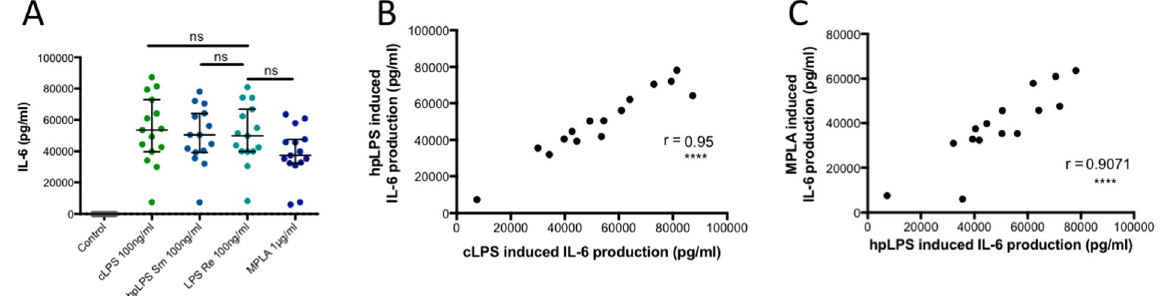
Figure 5. ( A ) IL-6 production by human adherent mononuclear cells activated by either conventional smooth E. coli O111:B4 LPS (cLPS) (100 ng/ml), highly purified S . abortus equi LPS (hpLPS) (100 ng/ml), highly purified rough S. minnesota LPS (ReLPS) (100 ng/ml) or MPLA (1 µ g/ml) for different donors. ( B ) and ( C ) correlation for IL-6 production by adherent mononuclear cells from individual donors between, hpLPS and cLPS or MPLA. Each dot represents one individual donor. **** p <